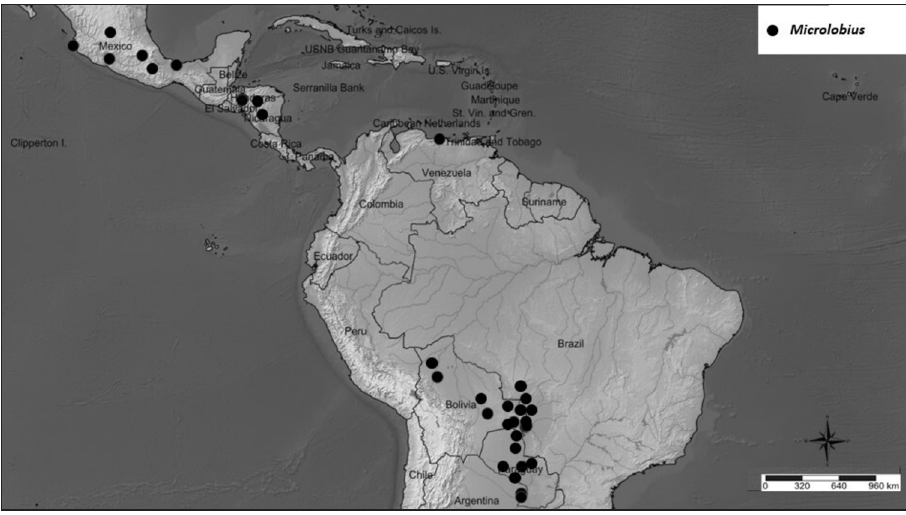
Figure 7. Distribution of Microlobius foetidus